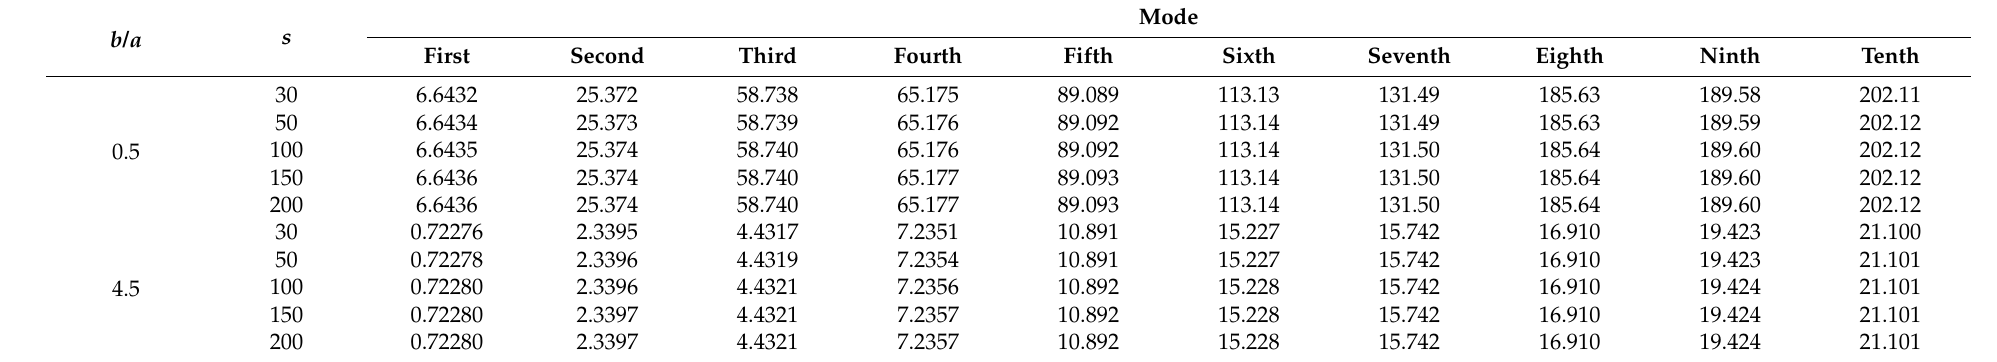
Table 9. Convergence of the dimensionless frequency parameter φ for the SSFF plates with aspect ratio χ equaling 0.5 and 4.5,